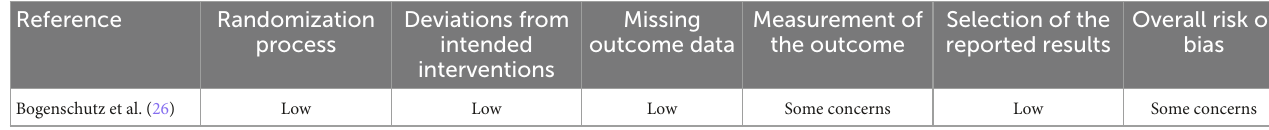
TABLE 4 Quality assessment of the included randomized intervention studies based on the risk of